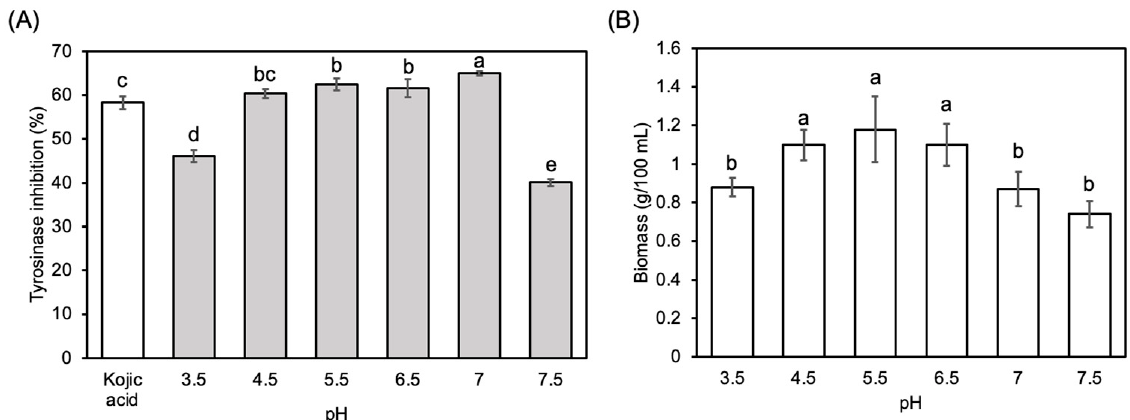
Figure 1. Ganoderma formosanum submerged fermentation using culture medium at di ff erent initial pH. ( A ) Tyrosinase inhibition activity of G. formosanum extracts (GFE; 1 mg/mL) obtained from me- dium with di ff erent initial pH. Kojic acid (0.25 mg/mL) was used as a positive control. ( B ) Biomass of GF-EPS obtained from medium with di ff erent initial pH. Means with di ff erent le tt ers indicate that they are signi fi cantly di ff erent ( p < 0.05).